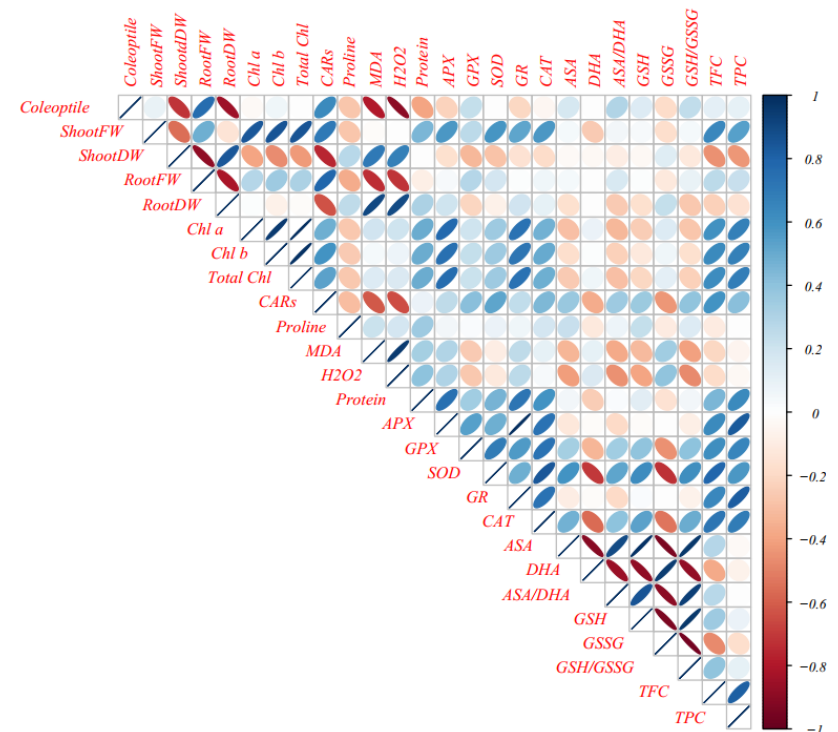
Figure 5. Heat map of Pearson’s correlation analysis for the response of Cucurbita sp. to induced- osmotic stress by mannitol and PEG application under in vitro condition. The heat map represents of Coleoptile length, Shoot and Root FW and DW, Chlorophyll a (Chl a), Chlorophyll b (Chl b), Total chlorophyll (Total Chl), Carotenoids (CARs), Proline content, Malondialdehyde (MDA), H 2 O 2 content, Total soluble protein content, Guaiacol peroxidase (GPX) activity, ascorbate peroxidase (APX) activity, Superoxide dismutase (SOD) activity, Reduced ascorbate (AsA), dehydroascorbate (DHA), AsA/DHA, Reduced glutathione (GSH), Oxidized glutathione (GSSG), GSH/GSSG, Total flavonoids content (TFC) and Total phenol content (TPC).